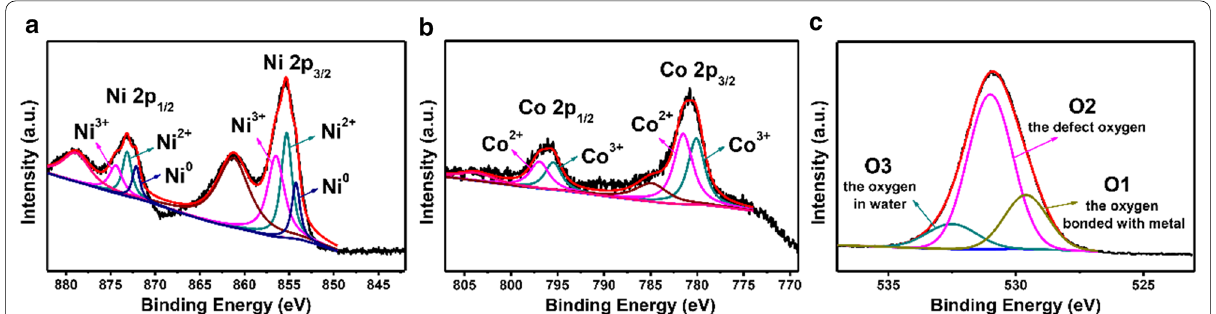
Fig. 3 X-ray photoelectron spectra of a Ni 2p, b Co 2p and c O 1 s of